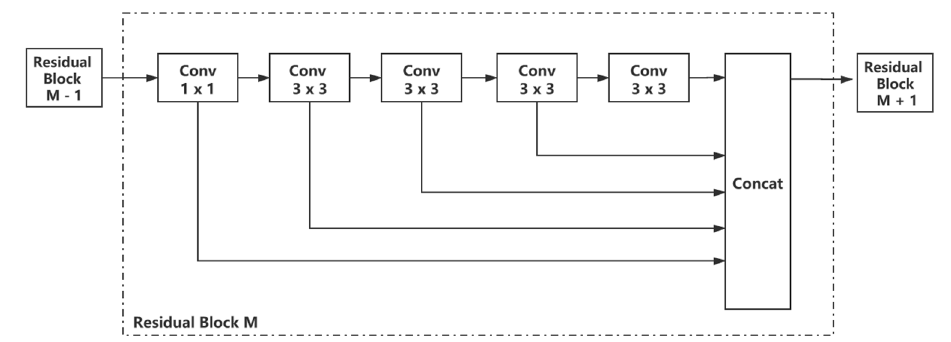
Figure 3. Architecture of the improved single-core multiscale residual block (SCMSRB).